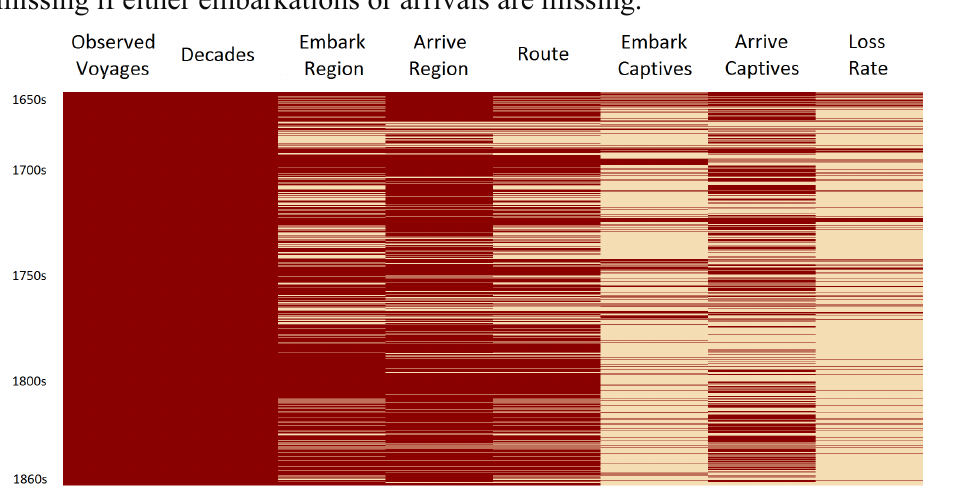
Figure 2. Missing Data (light spaces), by variable and by